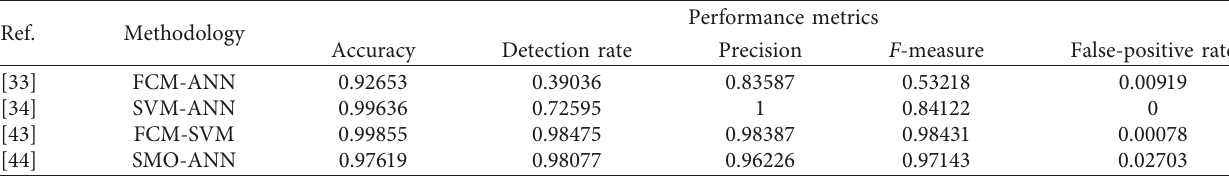
Table 4: Comparison of various methodologies based on different performance metrics for analysis attack. Ref.